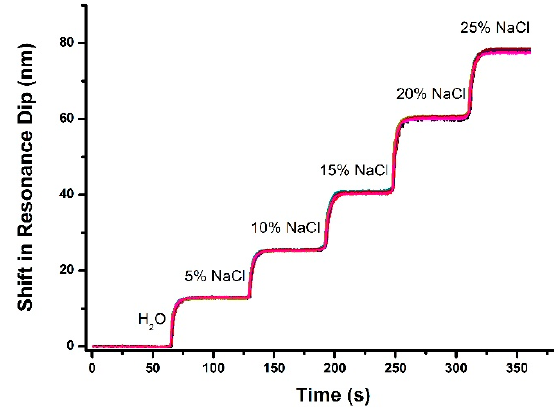
Figure 4. Shift of SPR dip versus salt concentration in water as detected by sensor sites within the 3 × 3 array.